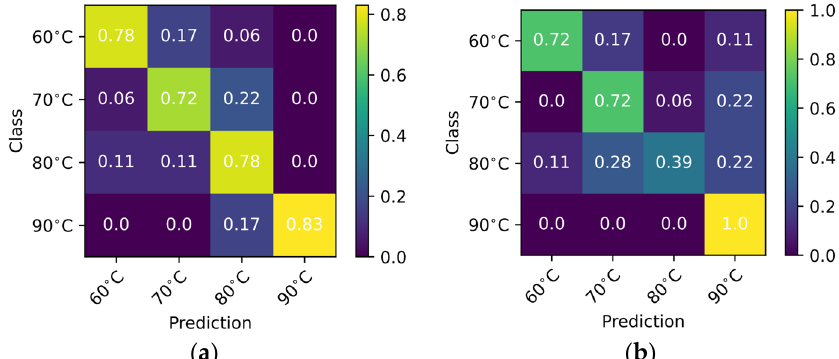
Figure 7. Confusion matrix of the MobileNet model for greyscale ( a ) and RGB color space ( b ) calculated from the test set.